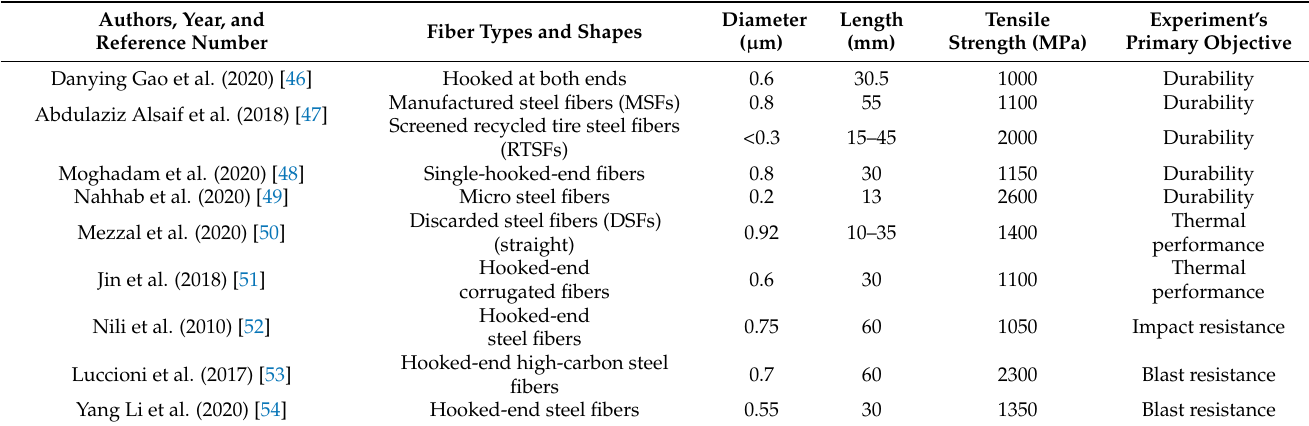
Table 1. Various steel fiber types, including their geometry and tensile